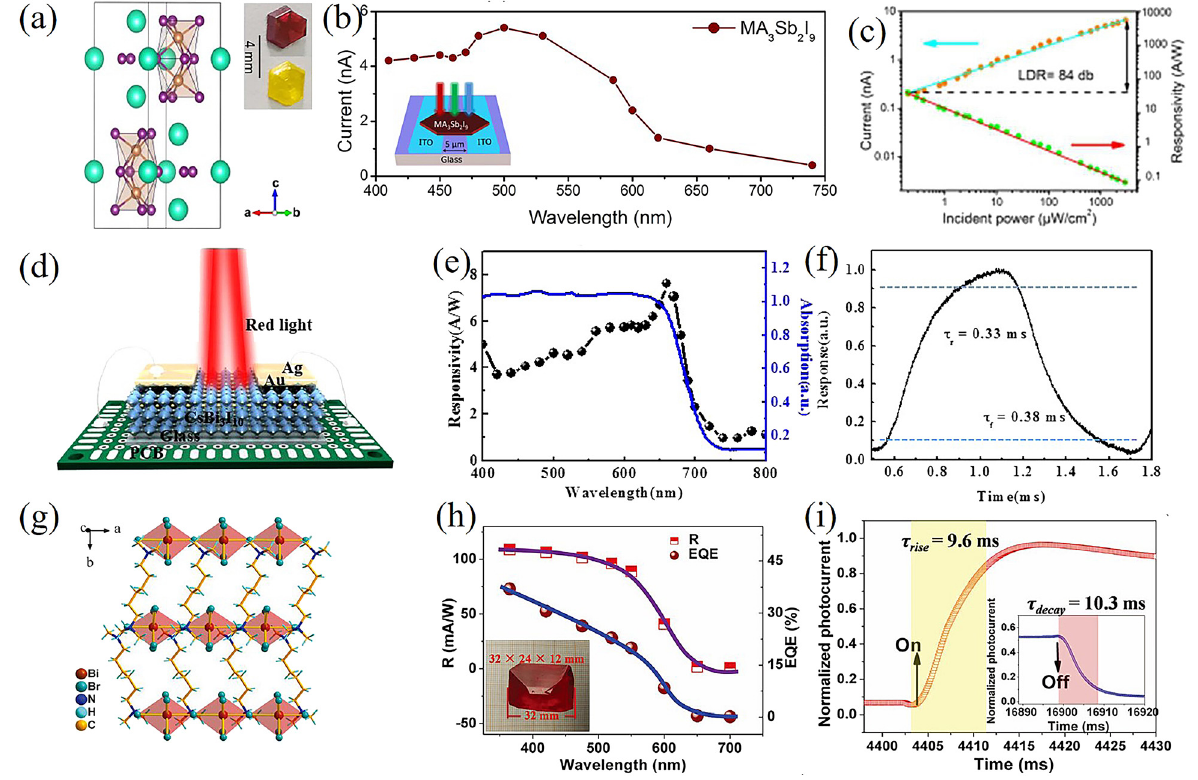
Figure 4: Sb 3 + -based and Bi 3 + -based perovskite variants for visible light photodetection. (a) crystal structure of MA 3 Sb 2 I 9 perovskite single crystals, upper left: Photograph of as-prepared MA 3 Sb 2 I 9 (dark red) and MA 3 Sb 2 Br 9 (light yellow) single crystals. (b) Wavelength-dependent photocurrent of MA 3 Sb 2 I 9 microcrystal (5 V bias, 1 mW/cm 2 ) photodetector, inset: schematic of the MA 3 Sb 2 I 9 microcrystal photodetector. (c) Power-dependent photocurrent and responsivity with 5 V bias (460 nm). Reproduced with permission. Copyright 2018, American Chemical Society [80]. (d) schematic illustration of the crystal structure and device structure of the CsBi 3 I 10 perovskite fi lm; the purple, green, and yellow spheres represent Bi, I, and Cs atoms, respectively. (e) Comparative presentation of the absorption spectrum of the CsBi 3 I 10 fi lm and the responsivity of the corresponding photodetectors. (f) the estimating rise time and fall time of CsBi 3 I 10 detectors. Reproduced with permission. Copyright 2017, American Chemical Society [81]. (g) crystal structure of the (TMHD)BiBr 5 single crystal. (h) wavelength dependence of photoresponsivity R and EQE of the (TMHD)BiBr 5 single-crystal